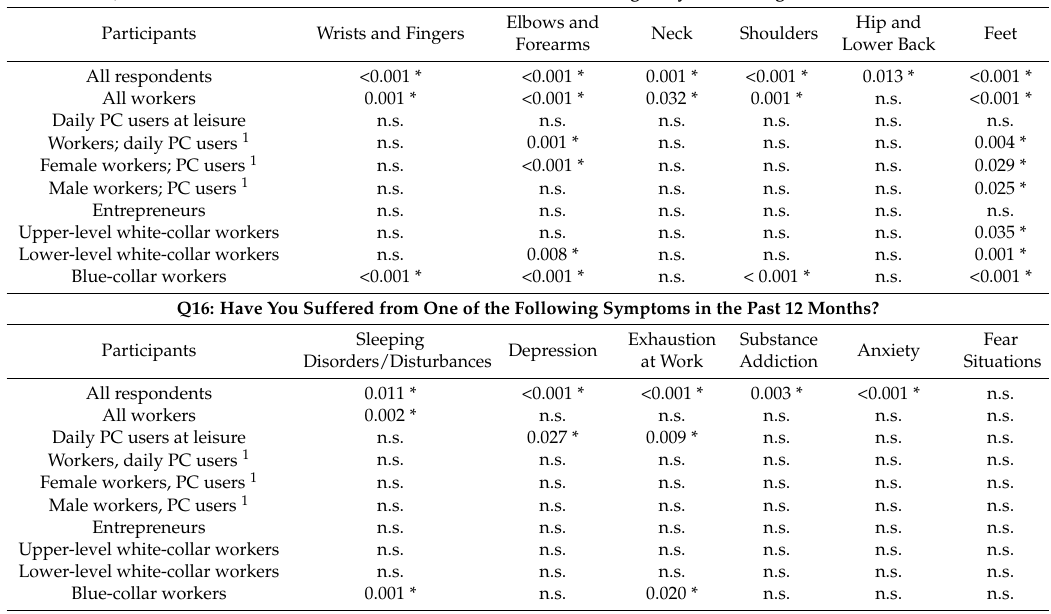
Table 2. The results of Mann-Whitney U-Test for Questions 13 and 16 between the ≥ 55-year-old persons and others (< 55 years) using the following groups: (1) all respondents; (2) all workers; (3) daily desktop computer (PC) users at leisure; (4) workers who use a desktop computer daily at work; (5) female workers who use a desktop computer daily at work; (6) male workers who use a desktop computer daily at work; (7) entrepreneurs; (8) upper-level white-collar workers; (9) lower-level white-collar workers; and (10) blue-collar